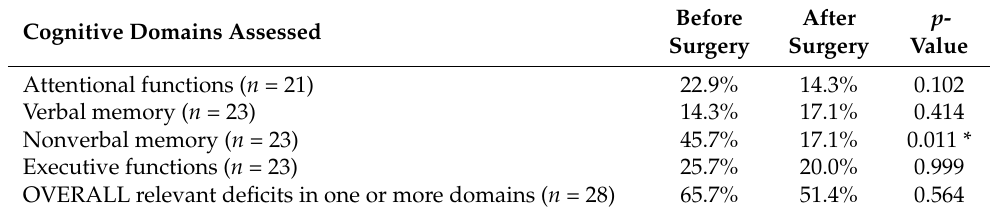
Table 2. Proportion of patients showing deficits in each assessed cognitive domain, compared between assessments using Cochran’s Q